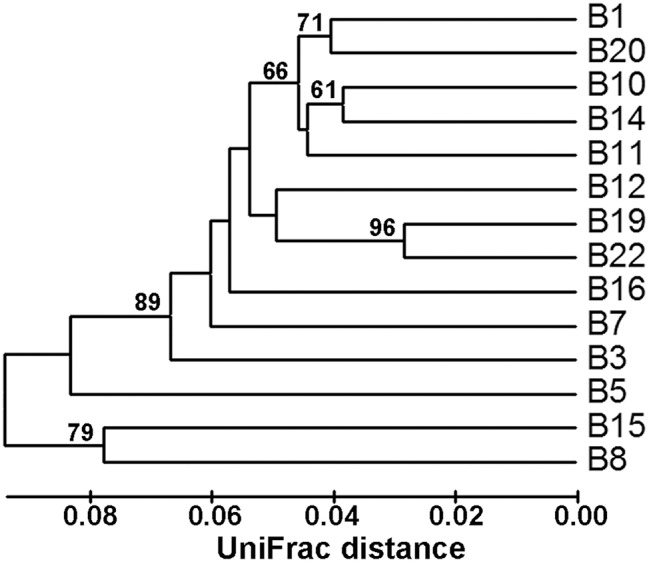
Hierarchical clustering dendrogram of the Bohai Sea sediment nifH-harboring microbial assemblages. This dendrogram was constructed by using the Fast UniFrac weighted and normalized Jackknife Environment Clusters statistical method with the use of the NifH protein sequence data. The percentage supports of the classification tested with sequence jackknifing resamplings are shown near the corresponding nodes.